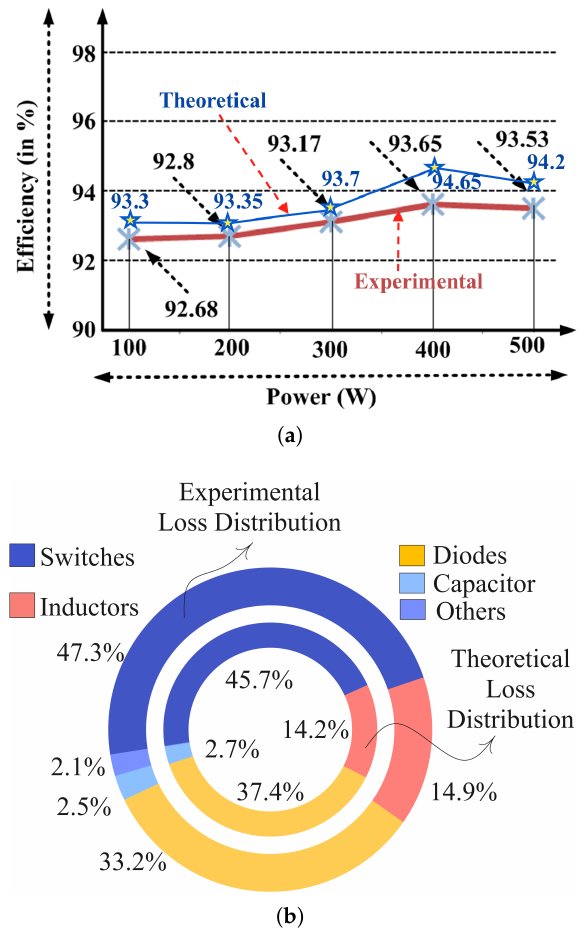
Figure 17. Plots: ( a ) efficiency curve for different powers, ( b ) loss distribution when output power 500